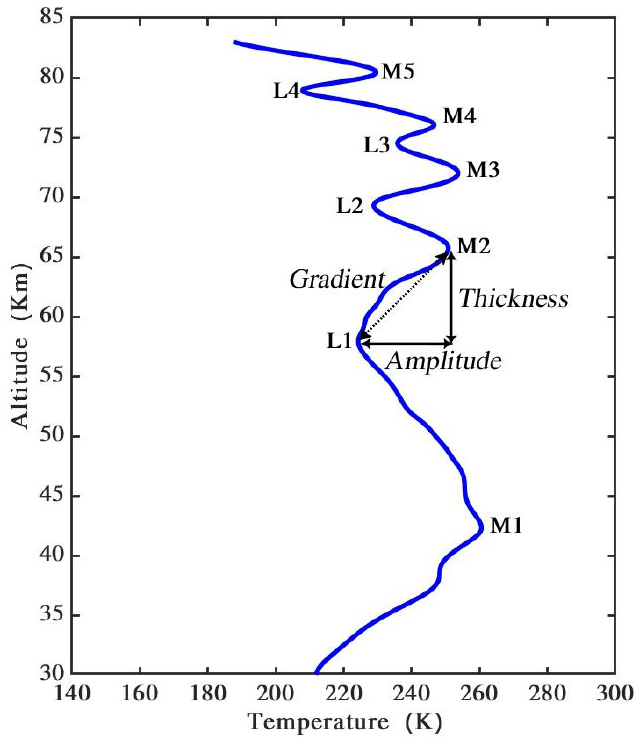
Figure 2. A sample middle atmospheric temperature profile obtained at OHP on 16 December 1982, illustrating the detection of MIL and their characteristics. The L i and M i correspond to the altitudes of minimum and maximum temperature for the evident i th structure in the data. The thickness (km), the amplitude (Kelvin), and the temperature gradient of the MIL retained are in italics in this case, with several large